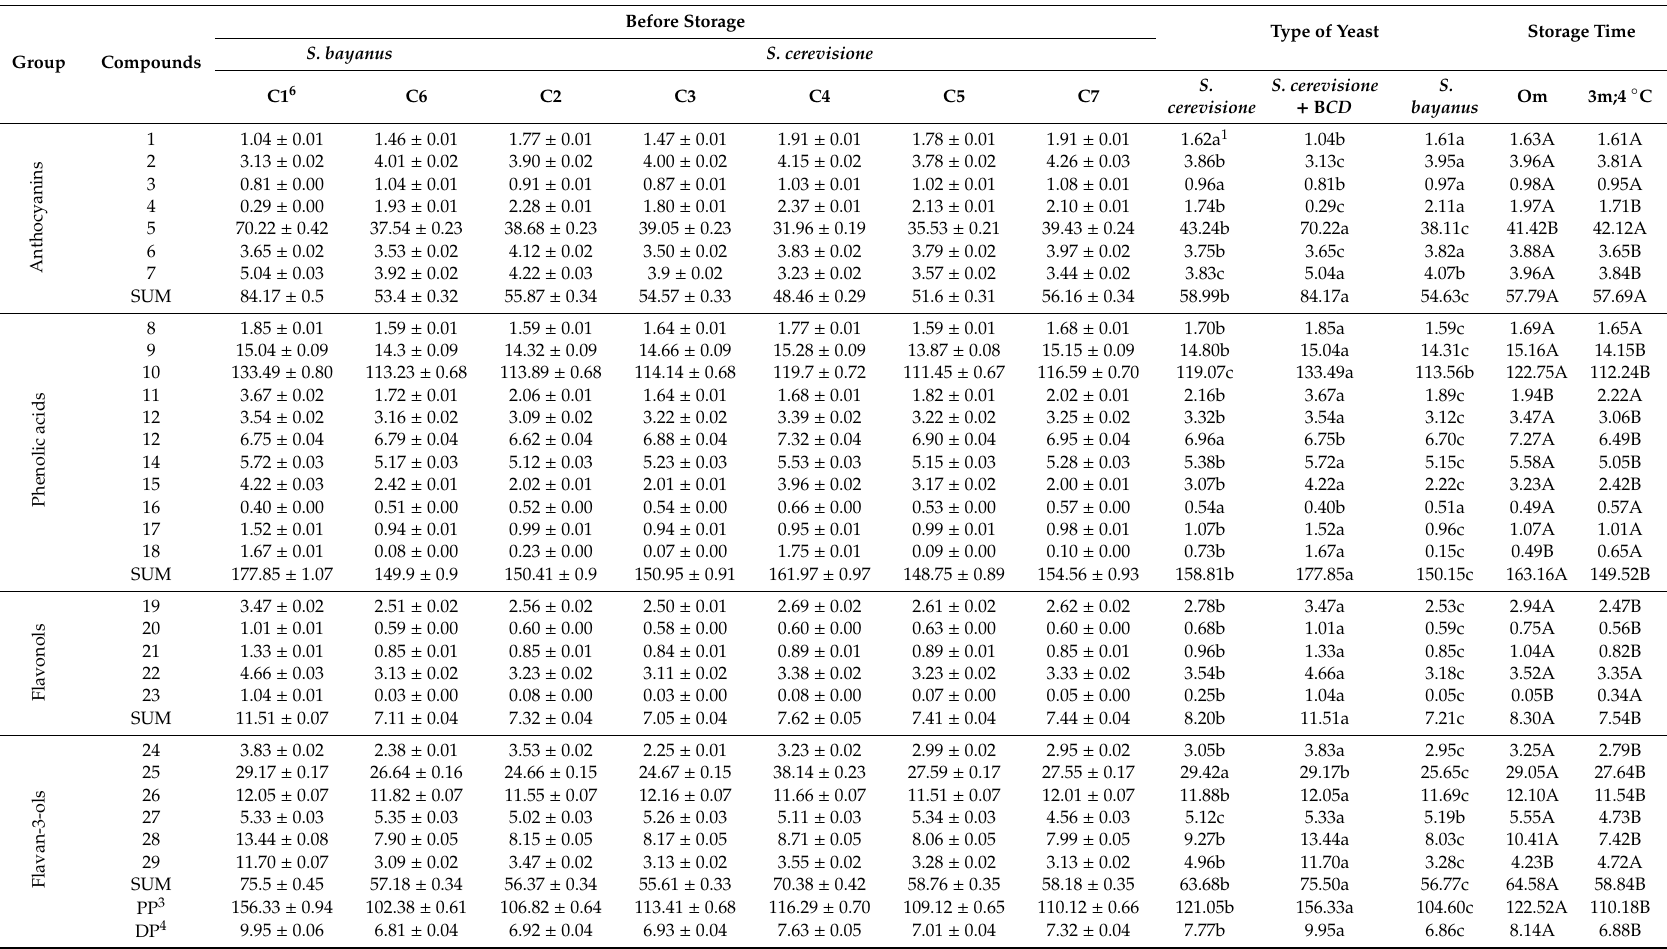
Type of Yeast Storage Time